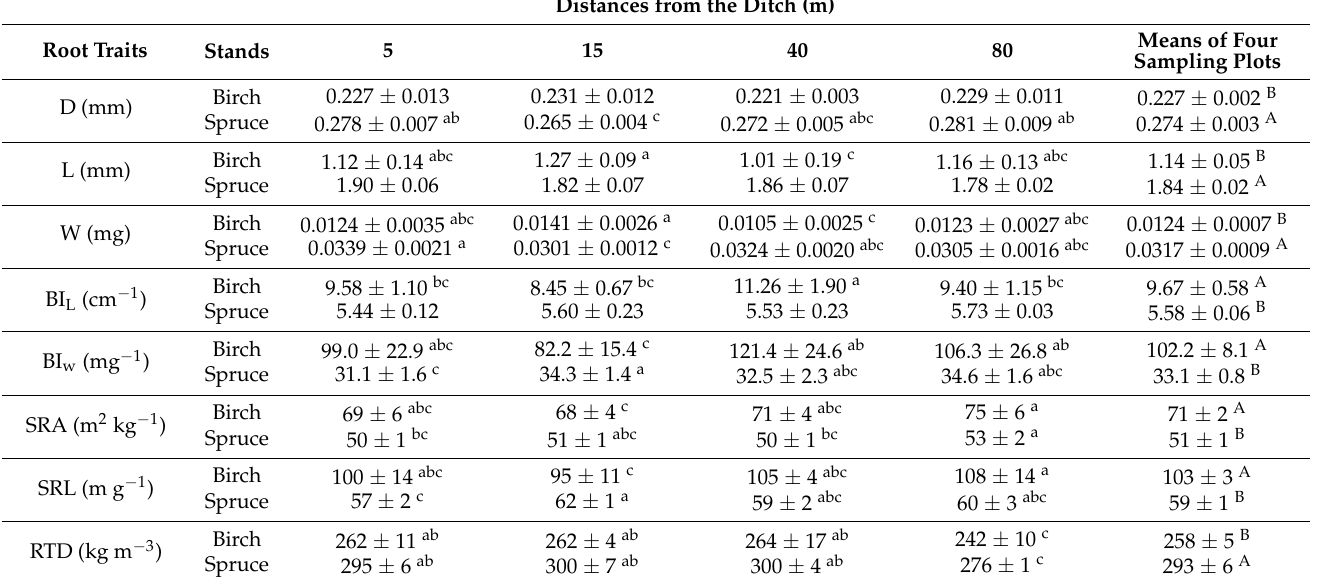
Table 3. Means ± standard errors of absorptive root morphological traits of the three replicate stands per sampling plot at the distances of 5, 15, 40, and 80 m from the ditch and of the four sampling plots per birch and spruce. D—diameter (mm), L—length (mm), W—dry weight (mg), BI L